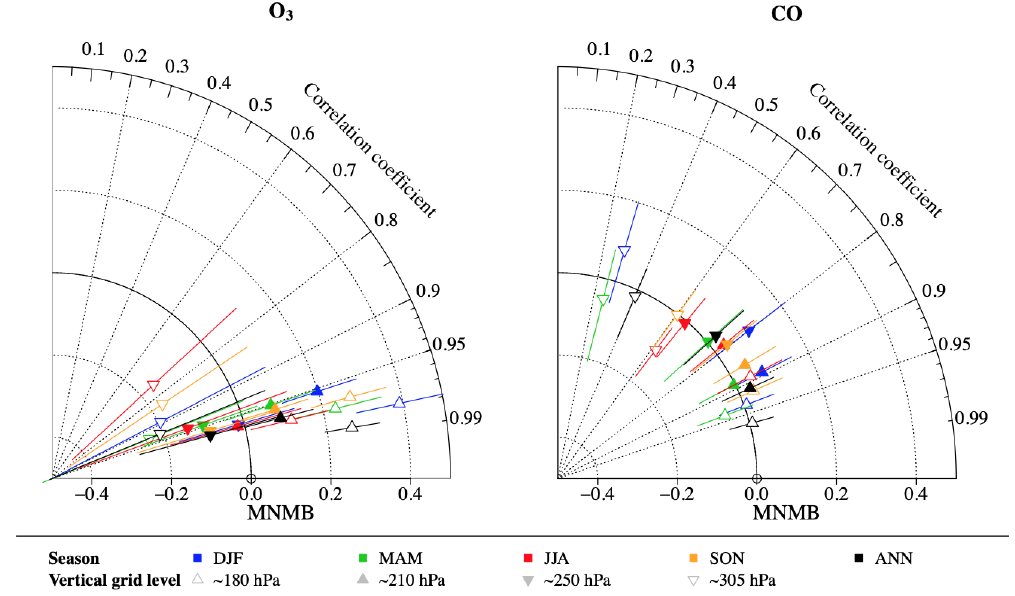
Figure 2. Taylor diagram comparing the mean and geographical correlation of the volume mixing ratio of ozone (left) and carbon monoxide (right) between the IAGOS database (Cohen et al., 2018, 2021) and the LMDZ-INCA model results. The error bars denote the first and third quartiles of the model to IAGOS biases for a given vertical level and